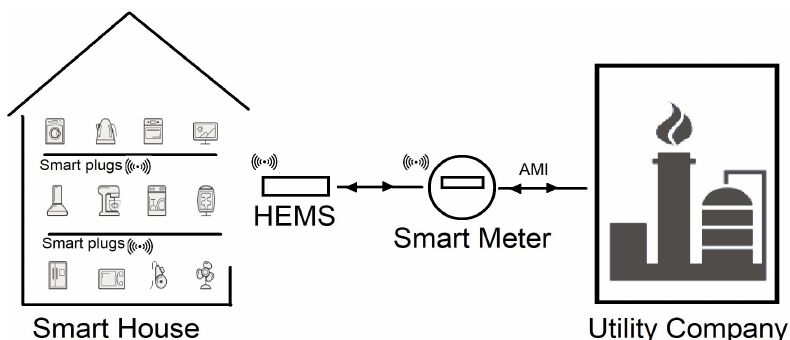
Figure 1. Simple layout of the proposed smart house and communication layout between HEMS and